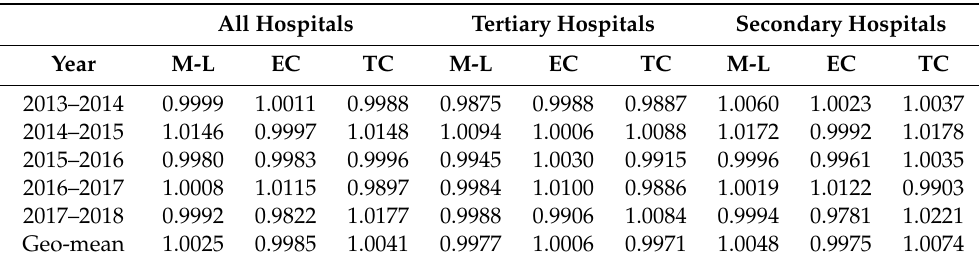
Table 1. The average productivity change and the decomposition. All